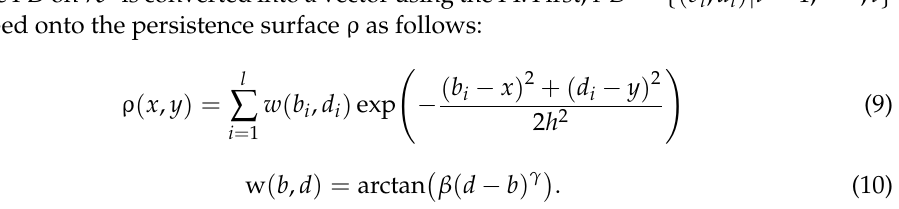
Figure 5. Schematic diagram illustrating the PH. ( a ) The balls are disconnected when the ball radius r is smaller than r 1 . ( b ) A loop emerges at r = r 1 = ( d ) PD representing the results of PH